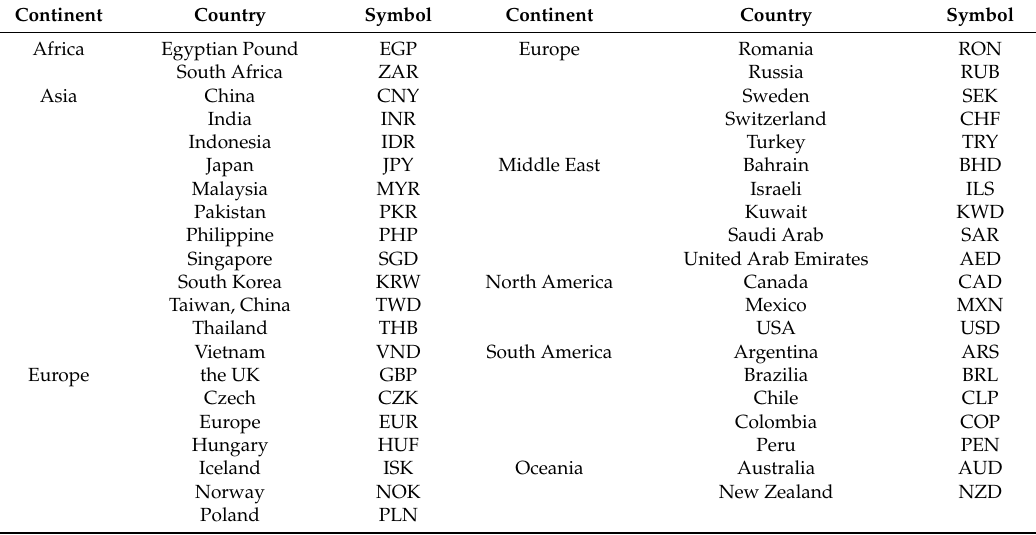
Table 1. Forty-one countries or regions and corresponding symbols.